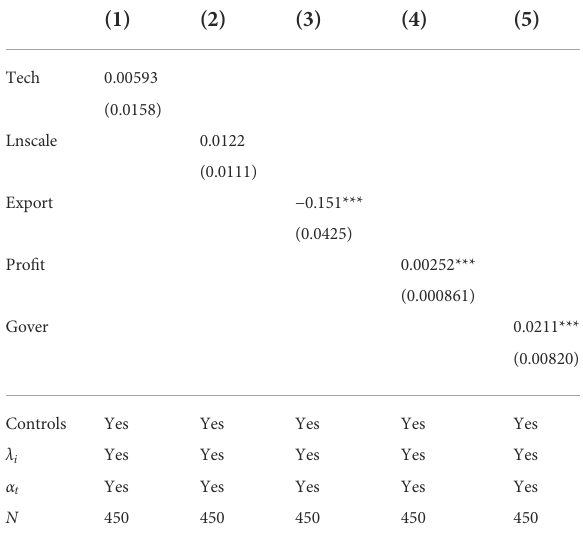
TABLE 5 Heterogeneity of FDI quality